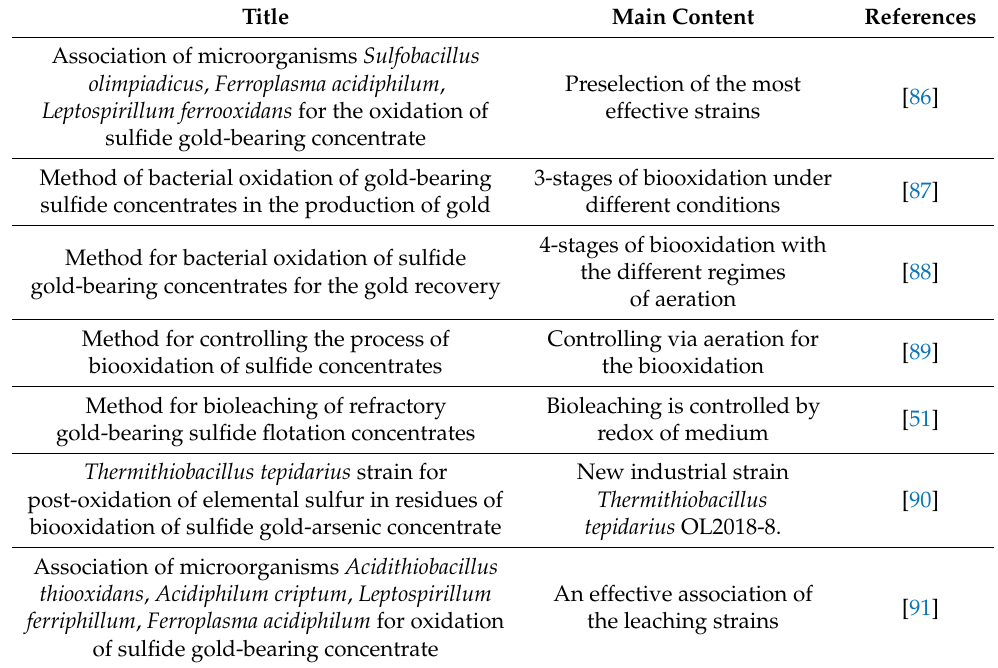
Table 6. The Russian Federation patents on the arsenopyrite bioleaching